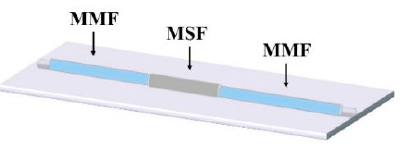
Figure 1. The sensor structure of MMF-MSF-MMF.